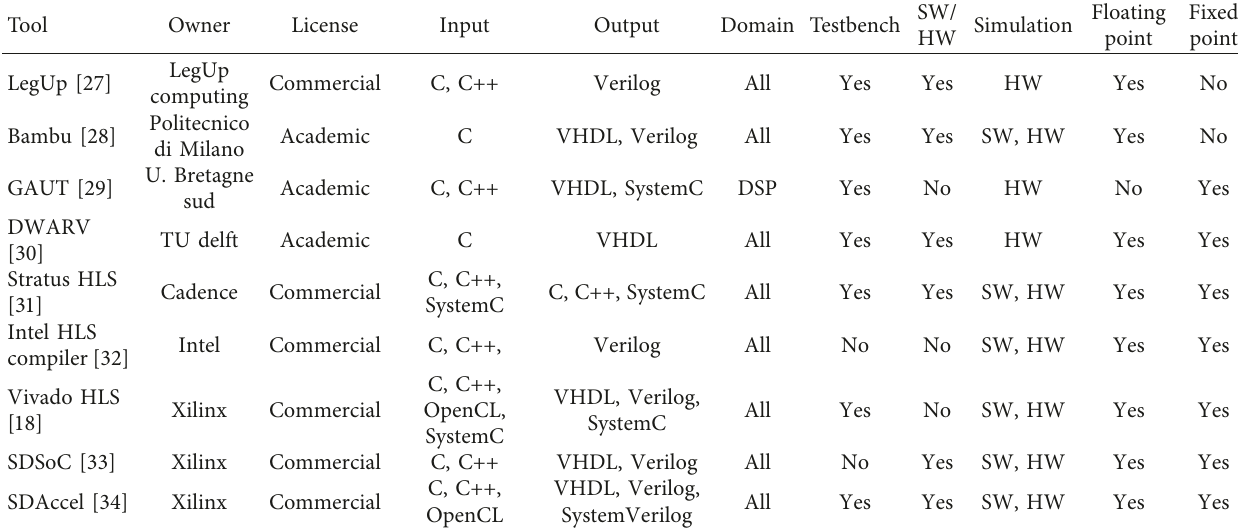
Table 1: Key features of discussed HLS